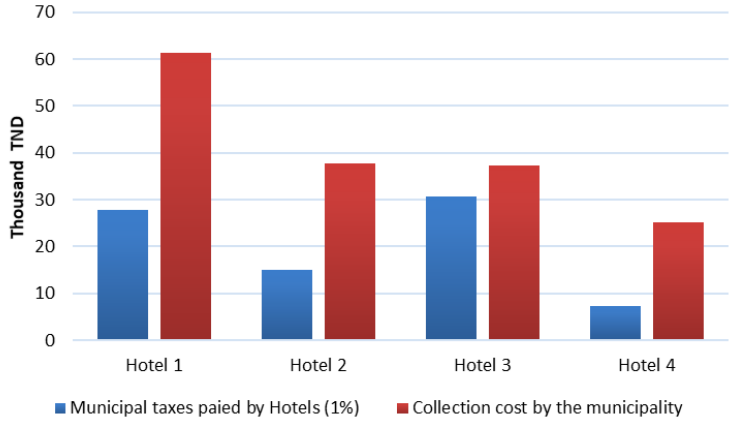
Figure 11. Comparison of the taxes paid by hotels to municipalities (1%) and the municipal collection costs from hotels.